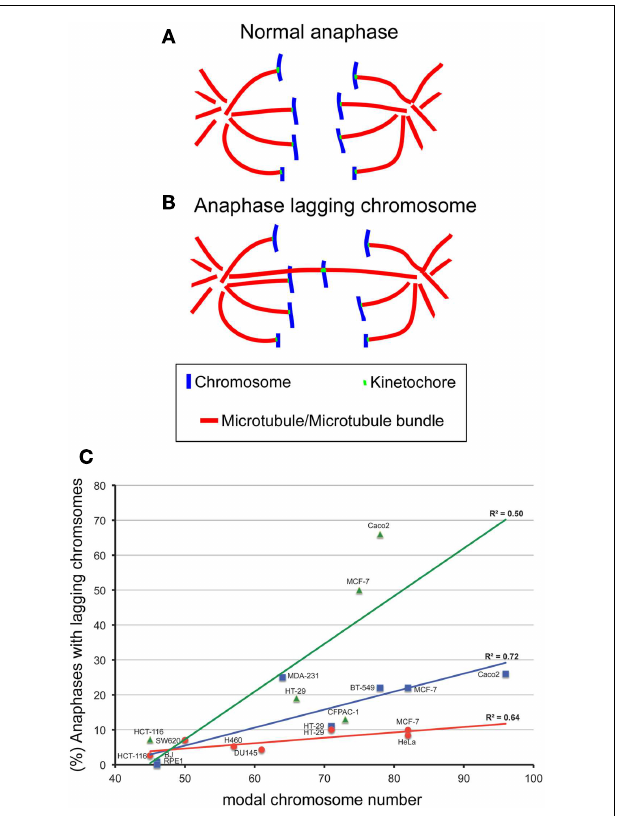
FIGURE 1 |The degree of aneuploidy directly correlates with CIN, as measured by analysis of anaphase lagging chromosomes . One way to measure CIN is by determining the rates of anaphase lagging chromosomes in dividing cells. In a normal anaphase, chromosomes are equally segregated to the two poles of the mitotic spindle, as illustrated by the diagram in (A) . Some dividing cells display anaphase lagging chromosomes (B) , single chromosomes that lag behind at the cell equator as all the other chromosomes move to the spindle poles. Anaphase lagging chromosomes are caused by merotelic kinetochore attachment (Cimini et al., 2001), a kinetochore mis-attachment in which a single kinetochore is bound to microtubules from two spindle poles instead of just one. (C) XY plot showing the relation between anaphase lagging chromosomes and modal chromosome number in various cell lines.The graph also shows linear fits and regression values ( R 2 ).The three colors refer to data sets from different labs: red is for data from the Cimini Lab [(Silkworth et al., 2009) and (Silkworth, Nardi, and Cimini, unpublished)]; blue is for data from the Pellman lab (Ganem et al., 2009); green is for data from the Compton lab (Thompson and Compton, 2008). Karyotype information for cell lines from the Cimini Lab and the Pellman Lab was obtained fromThe American Type Cell Culture website (ATCC). Karyotype information for cell lines from the Compton Lab is that reported in (Thompson and Compton, 2008). Although there is a general trend in which higher chromosome modal number correlates with higher rates of anaphase lagging chromosomes, there is a certain degree of variability between different labs. Correlation analysis showed significant correlation between aneuploidy and CIN for the cell lines in blue (Pearson R = 0.85, P < 0.05) and those in red (Pearson R = 0.80, P < 0.05), but no significant correlation for the data shown in green ( R = 0.71, P >